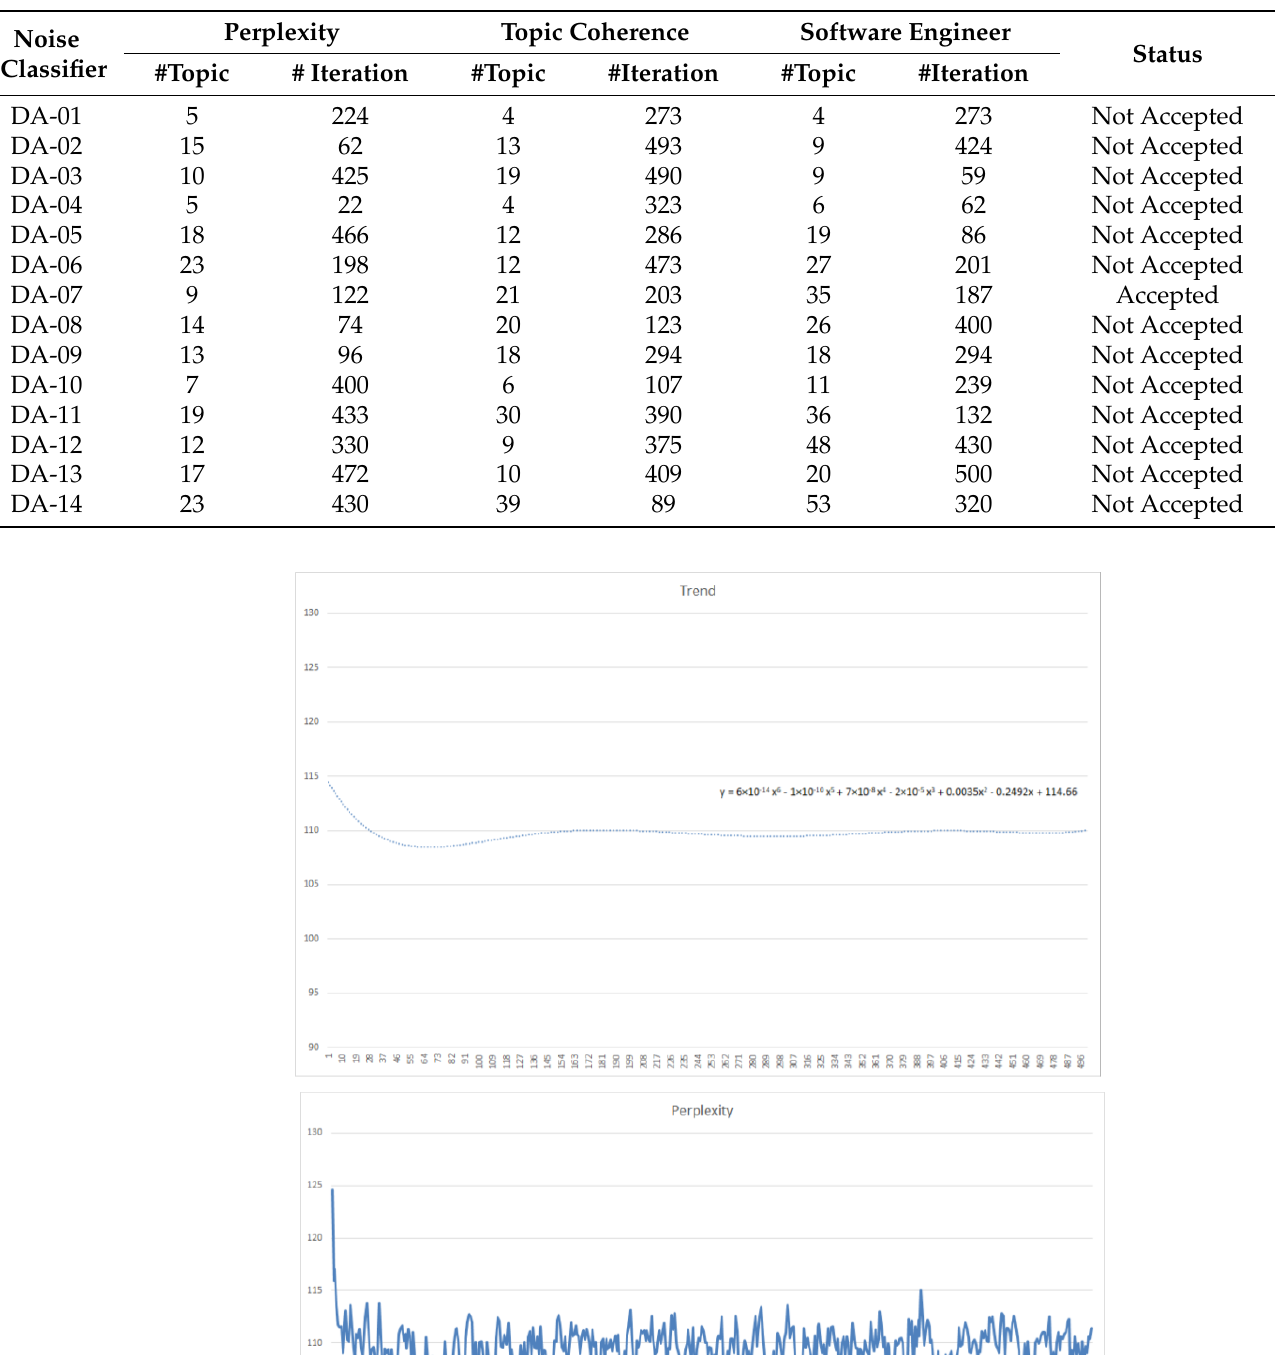
Table 2. The Optimal Number of Topics and Number of Iterations for Each SRS Document.